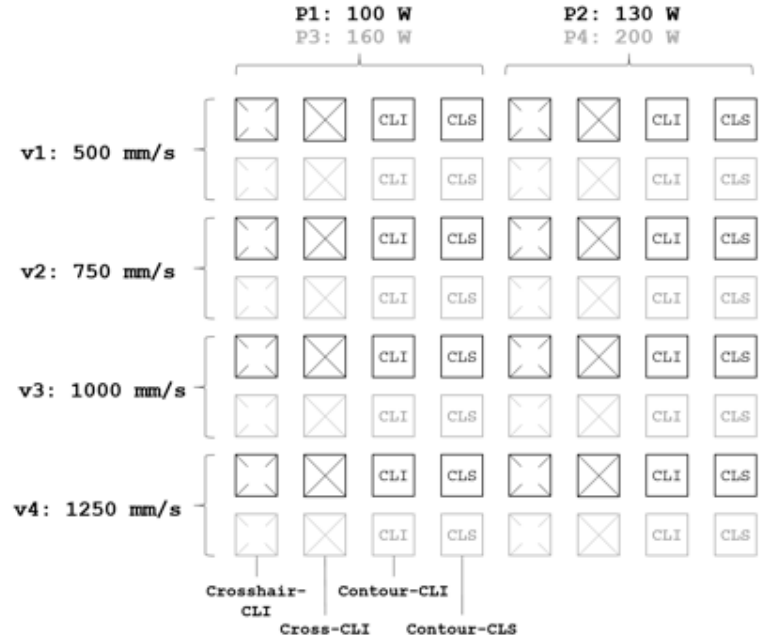
Figure 4. Overview of the initial parameter screening setup (Step 1).